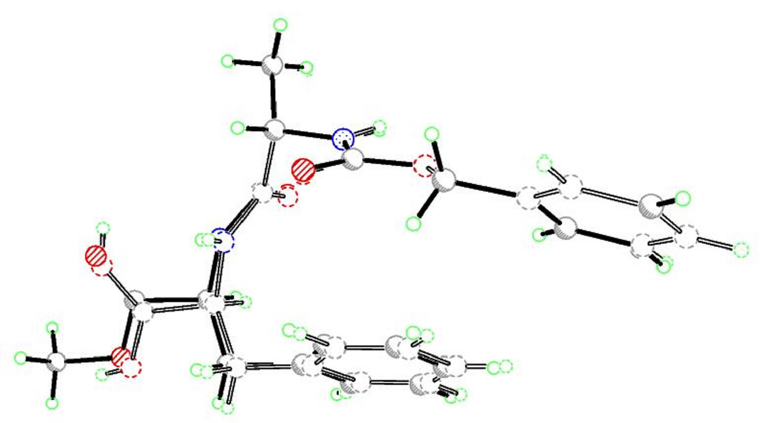
Figure 4. A least-squares fit of the title compound (Z-AF-OMe, full bonds) with